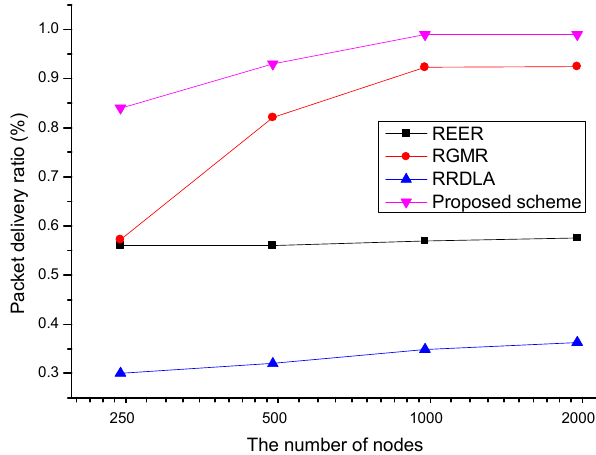
Figure 12. Packet delivery ratio vs. the number of nodes with 90% of the link